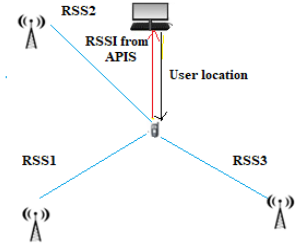
Figure 7. Received signal strength.